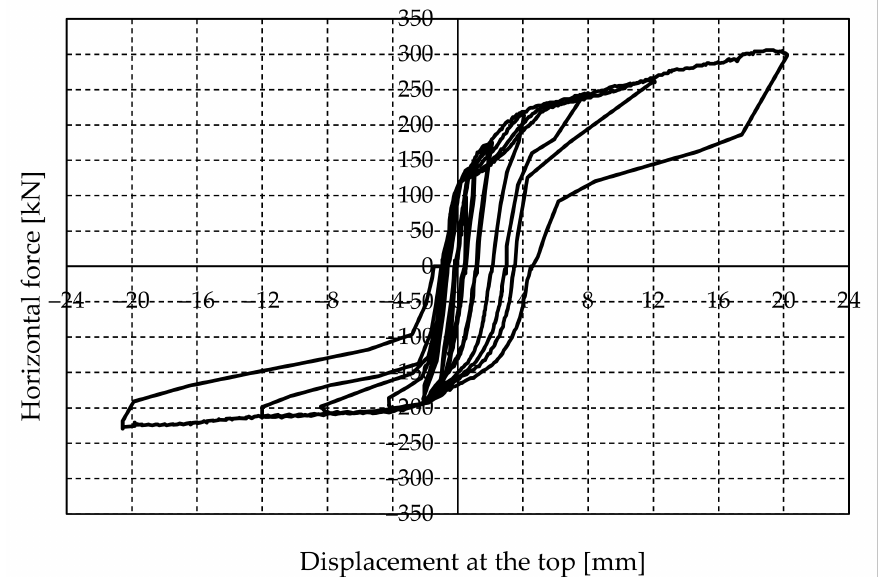
Figure 20. Force—displacement diagram for W3 (V = 460 kN, σ v = 0.8 N/mm 2